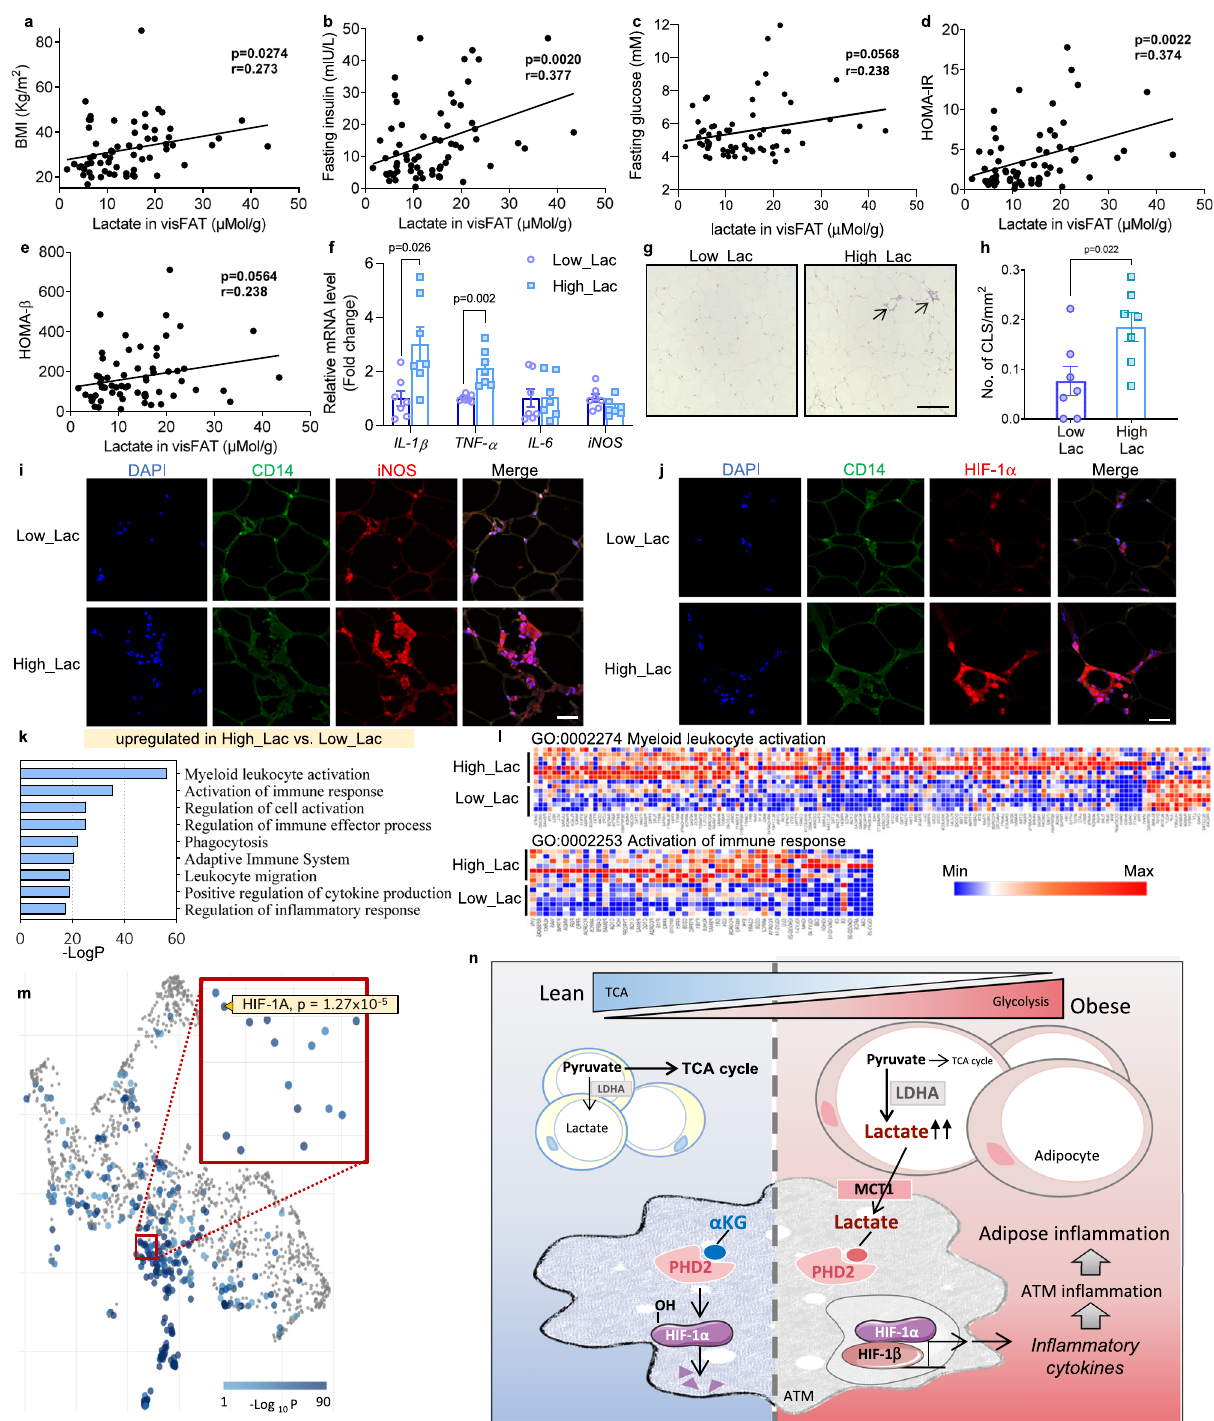
Fig. 7 | Human adipose lactate level is positively correlated with adipose in fl ammation and insulin resistance independent of BMI. a – e Correlation between lactate levels in human omental adipose tissues with a BMI, b fasting insulin, c fasting glucose, d HOMA-IR and e HOMA- β index. n =65 subjects. f – m 7 omental fat samples were randomly selected from low and high lactate groups (Low_Lac vs. High_Lac). f In fl ammatory cytokines mRNA level in adipose. n =7 individuals. g HE staining of omental fat; scale bar, 200 μ m. Arrows point at the crown like structures (CLSs). h CLS numbers in omental fat. n =7 individuals. i , j Immuno fl uorescence staining of iNOS and HIF-1 α and human macrophage